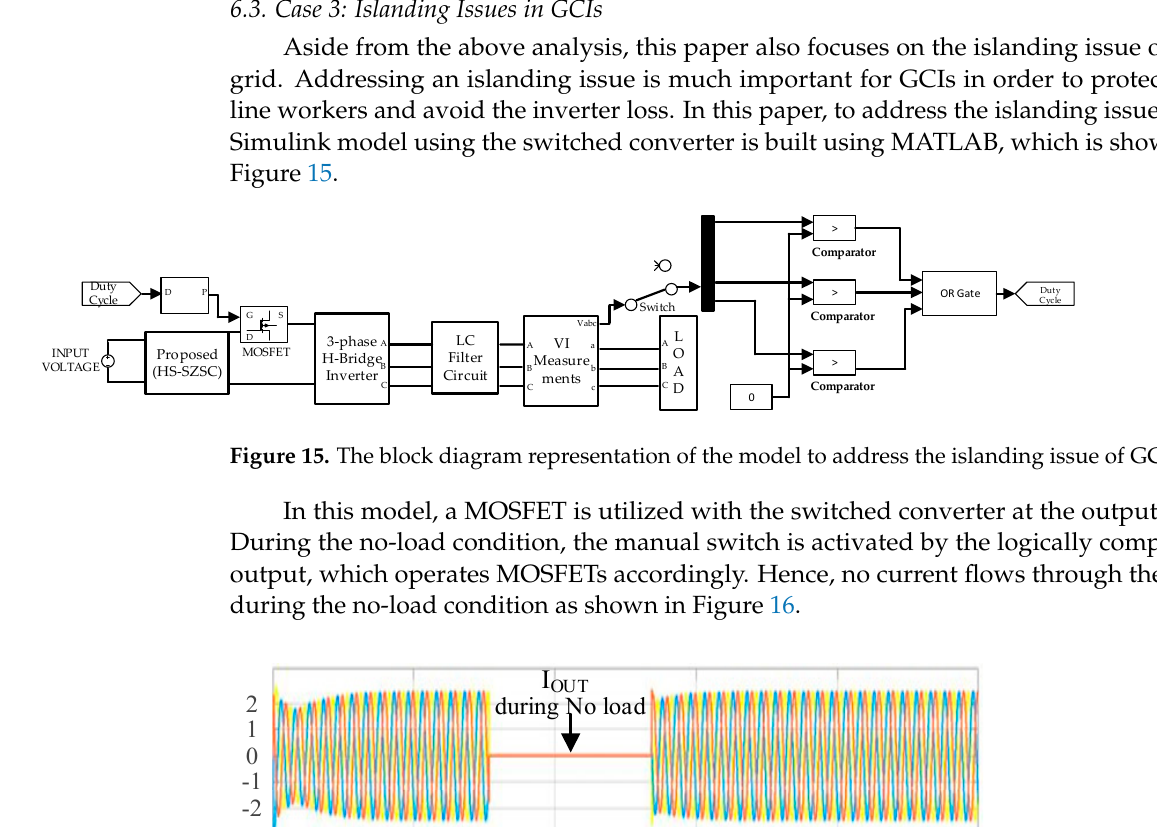
Figure 15. The block diagram representation of the model to address the islanding issue of GCIs.